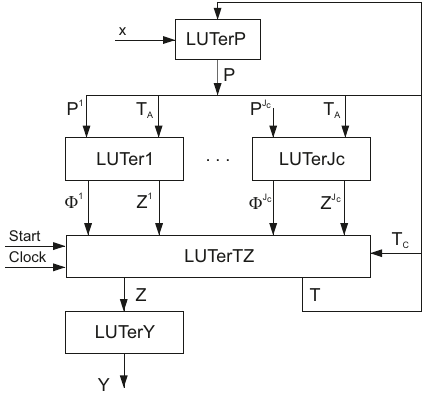
Figure 4. Structural diagram of LUT-based MP C Y Mealy